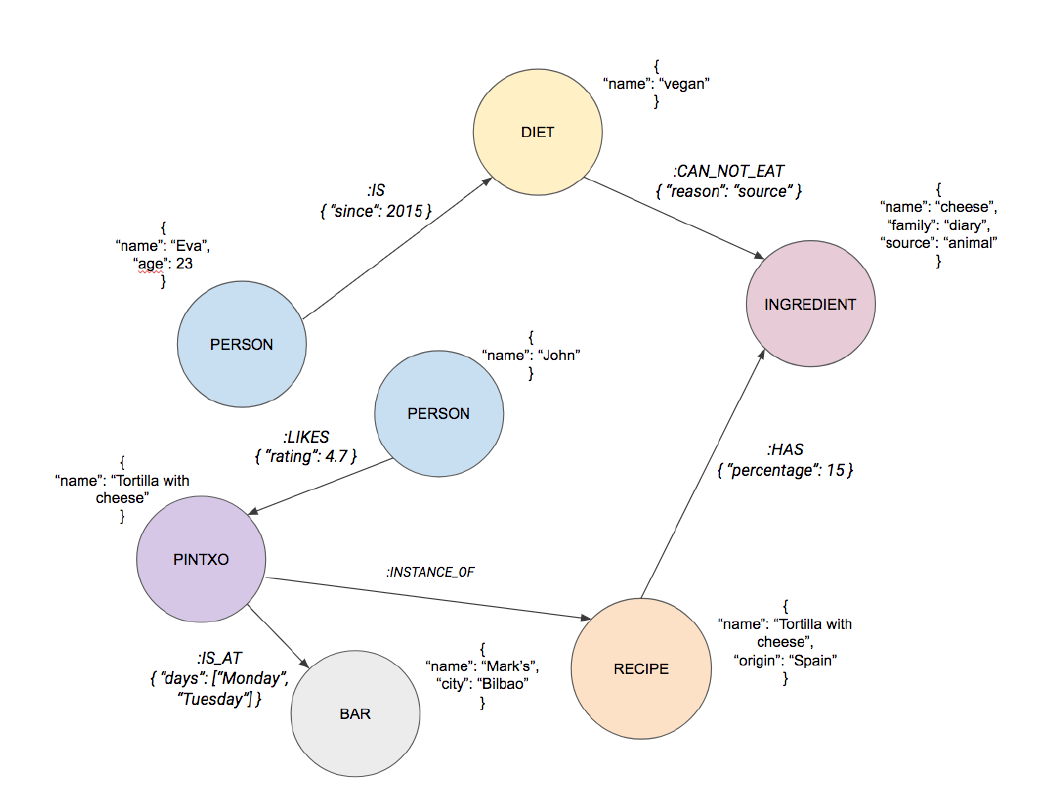
Figure 2. Graph data model and example for ’cheese